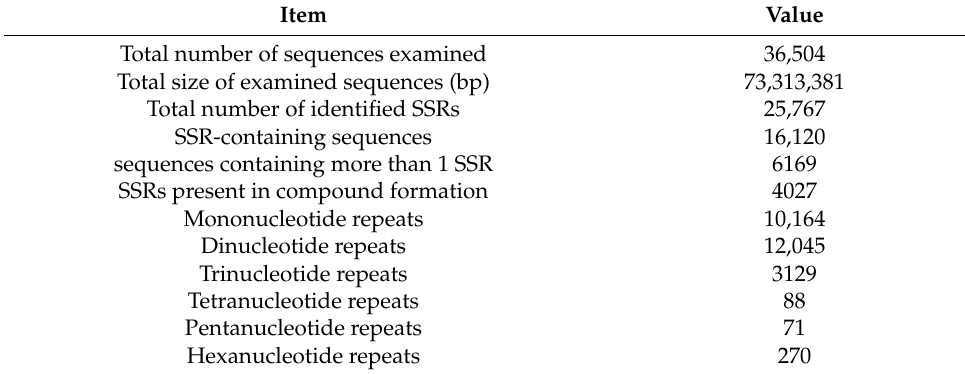
Figure 5. Genes and TF genes involved in polyphyllin biosynthesis. ( A ) Putative polyphyllin biosynthetic genes. ( B ) Putative TF genes related to the biosynthesis. Table 2. Statistics of SSRs from the